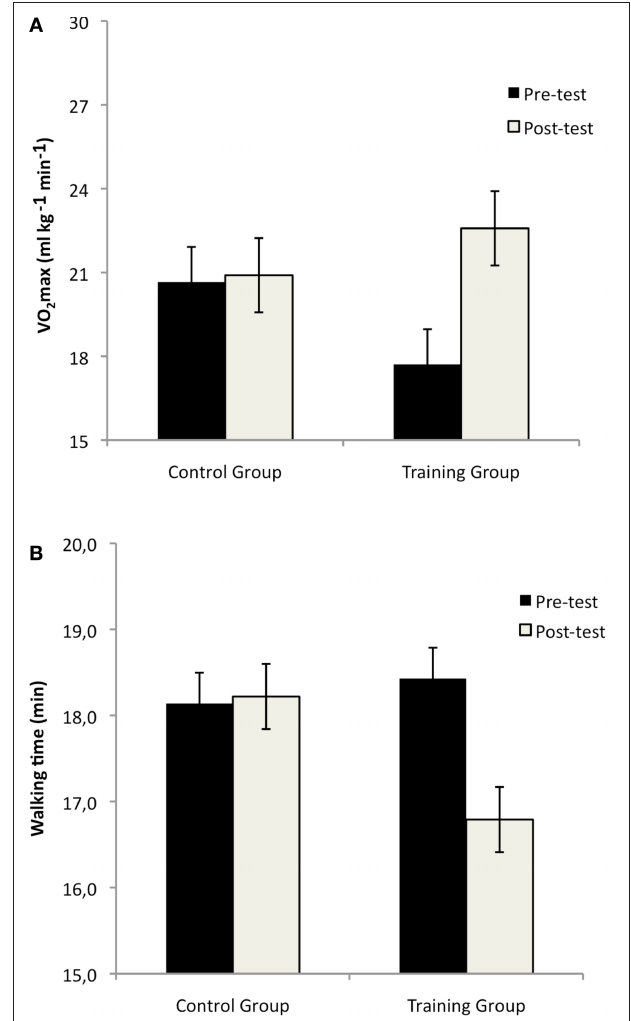
FiGure 2 | mean Vo max estimate (A) and walking time (b) in the 2 rockport one-mile test at pre-test and post-test sessions, in the control and the training groups (bars represent standard